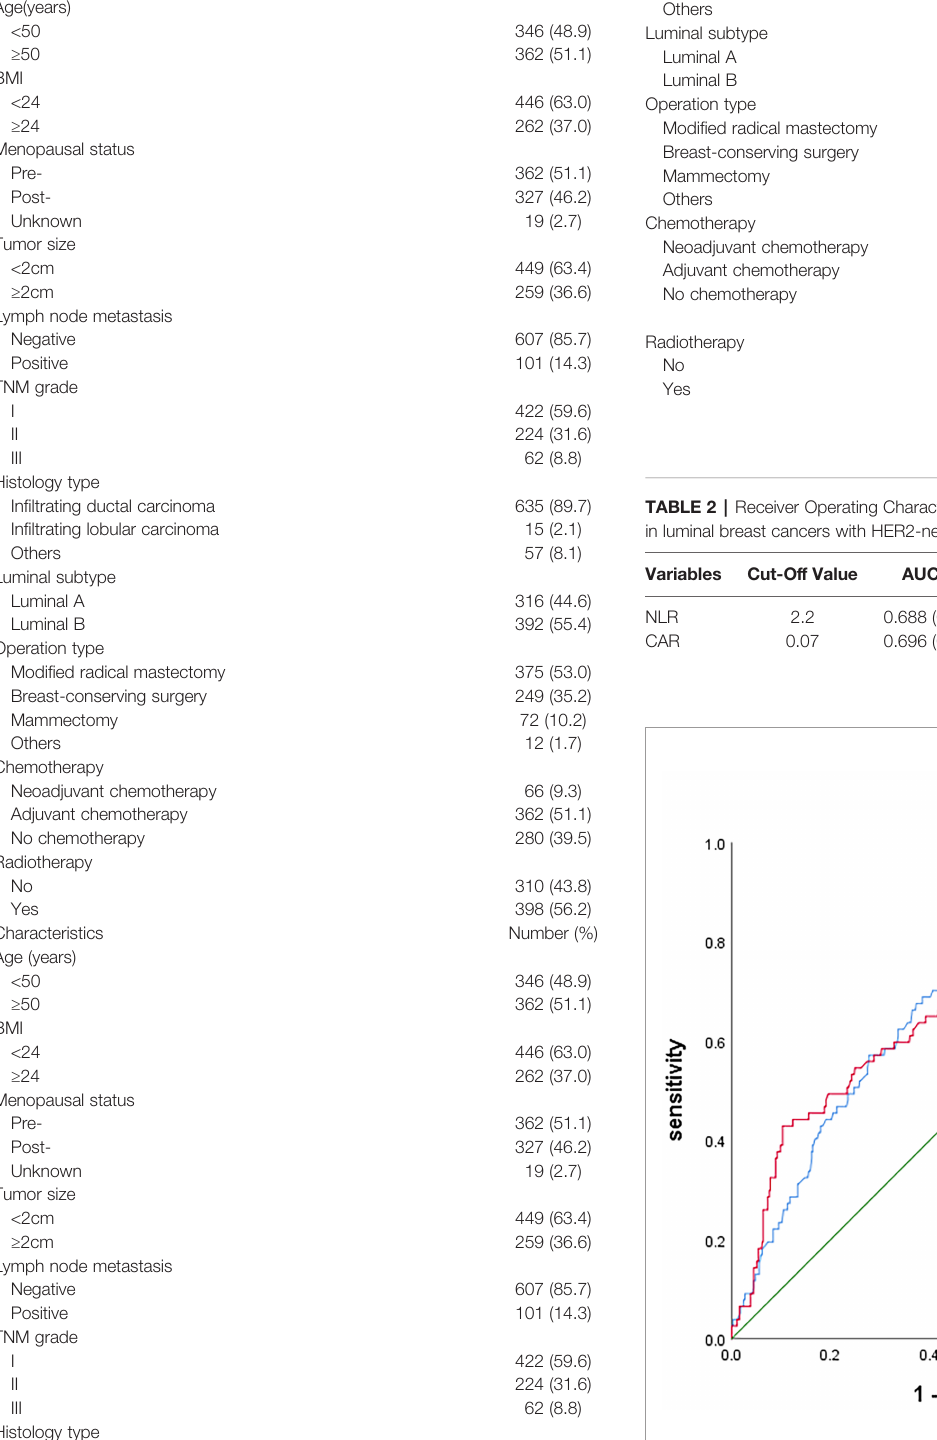
FIGURE 2 | The receiver operating characteristic (ROC) curves of neutrophil- to-lymphocyte ratio (NLR) and c-reactive protein/albumin ratio